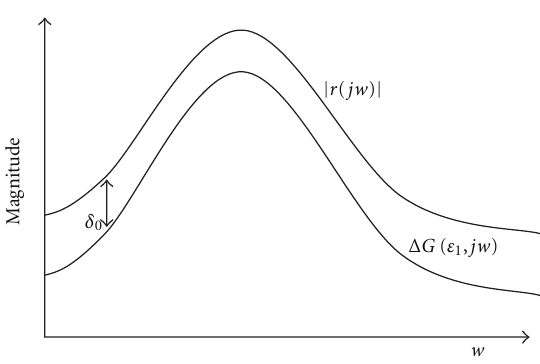
Figure 1: Definition of the norm distance δ 0